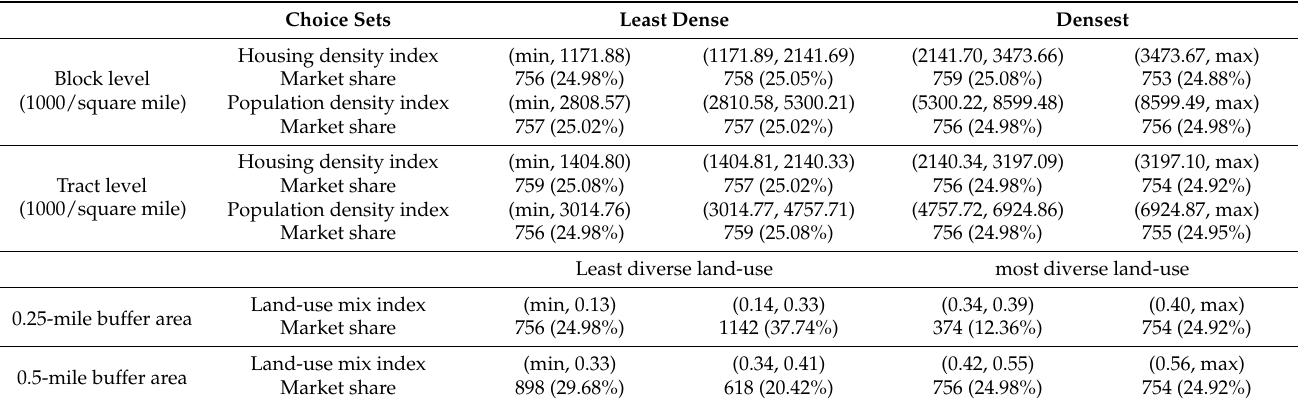
Table 2. Categories of density and land-use mix related choice